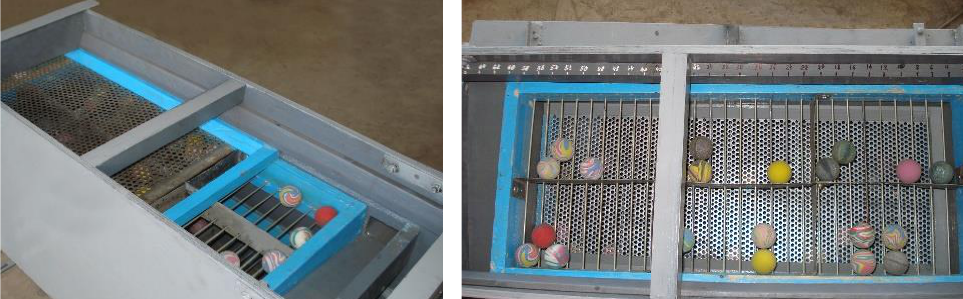
Figure 3. Ball purifiers will settle the installation for calibration.